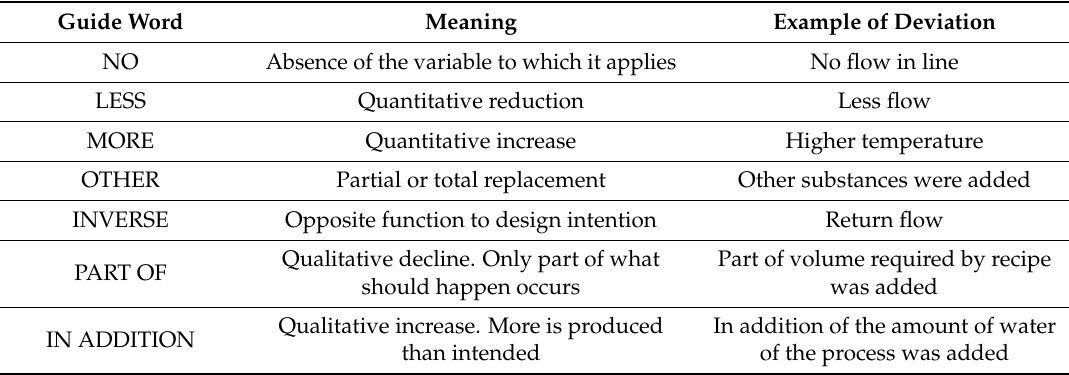
Figure 2. HAZard and OPerability analysis (HAZOP) process. Table 1. HAZard and OPerability analysis (HAZOP) guide word method. Source: ISO 31010: 2011 [27].